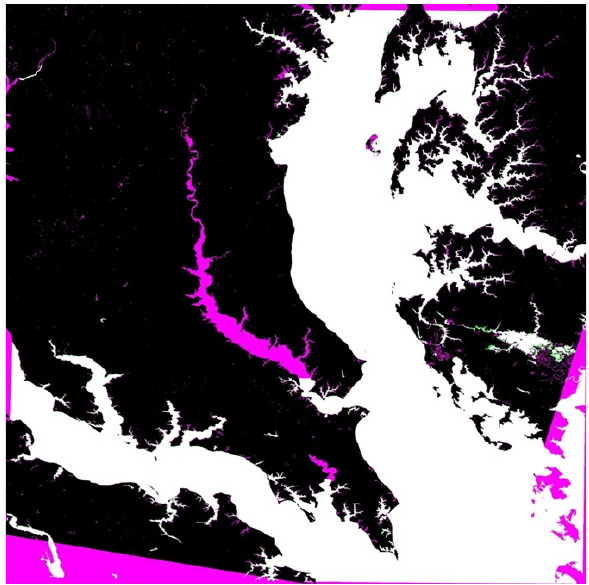
Figure 2. Chesapeake Bay, eastern USA. Comparison of SWBD and AWBD. Coincident water bodies are in white; ASTER only water bodies are in green; SWBD only water bodies are in magenta.